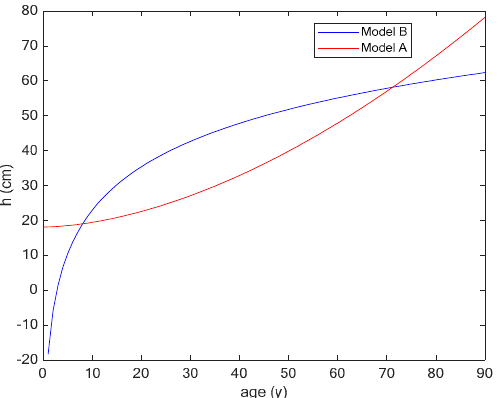
Figure 4. Comparison of height estimation as a function of age in Eunicella verrucosa by using model A and B.